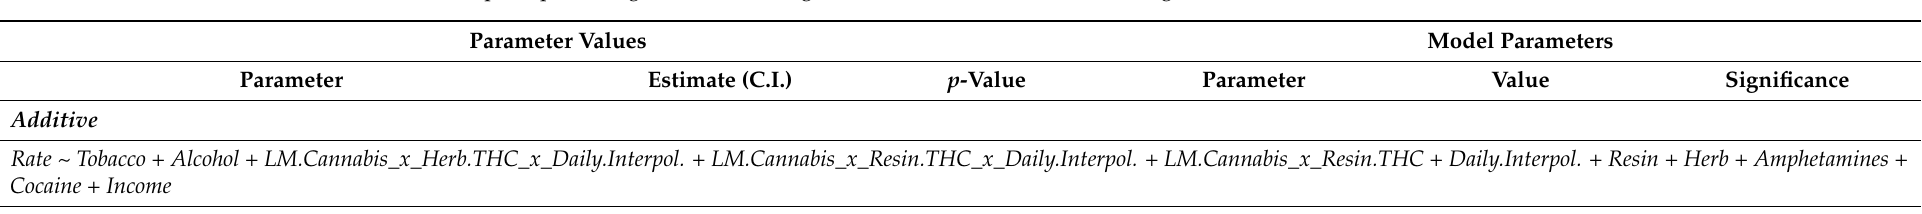
Table 6. Geotemporospatial Regressions for Congenital Posterior Urethral Valve Congenital